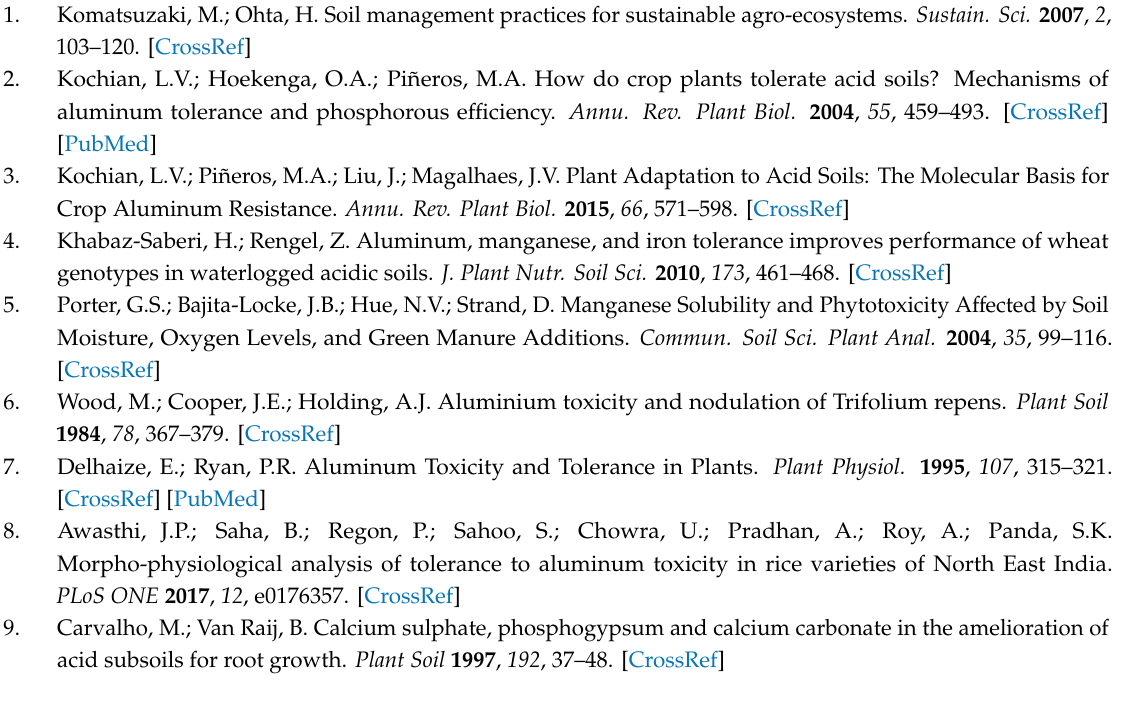
Figure S1: Semiquantitative PCR expression of internal standards used in this study to normalize the gene of Figure S3: Soybean shoots growth inhibition in neutral and acidic soil. Figure S4: Soybean roots growth inhibition in neutral and acidic soil. Figure S5: Al content of the roots of soybean plants grown in neutral and acidic soil. Table S1: Sequence information of primers used for qRT-PCR. Table S2: E ffi ciency of designed primer pairs used for qRT-PCR amplification. Table S3: Changes in shoots, fresh and dry weight of soybeans grown in artificial and natural soils. Table S4: Changes in roots, fresh and dry weight of soybeans grown in artificial and natural